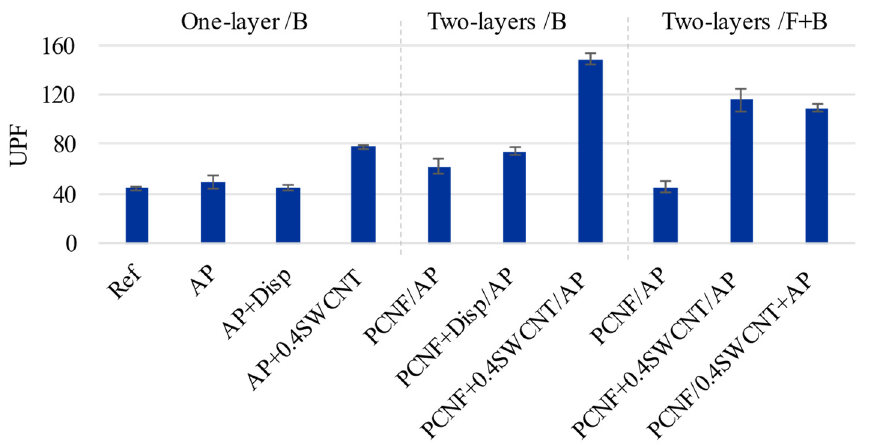
Figure 7. The effect of printing on the fabric’s ultraviolet protection factor (UPF) properties.